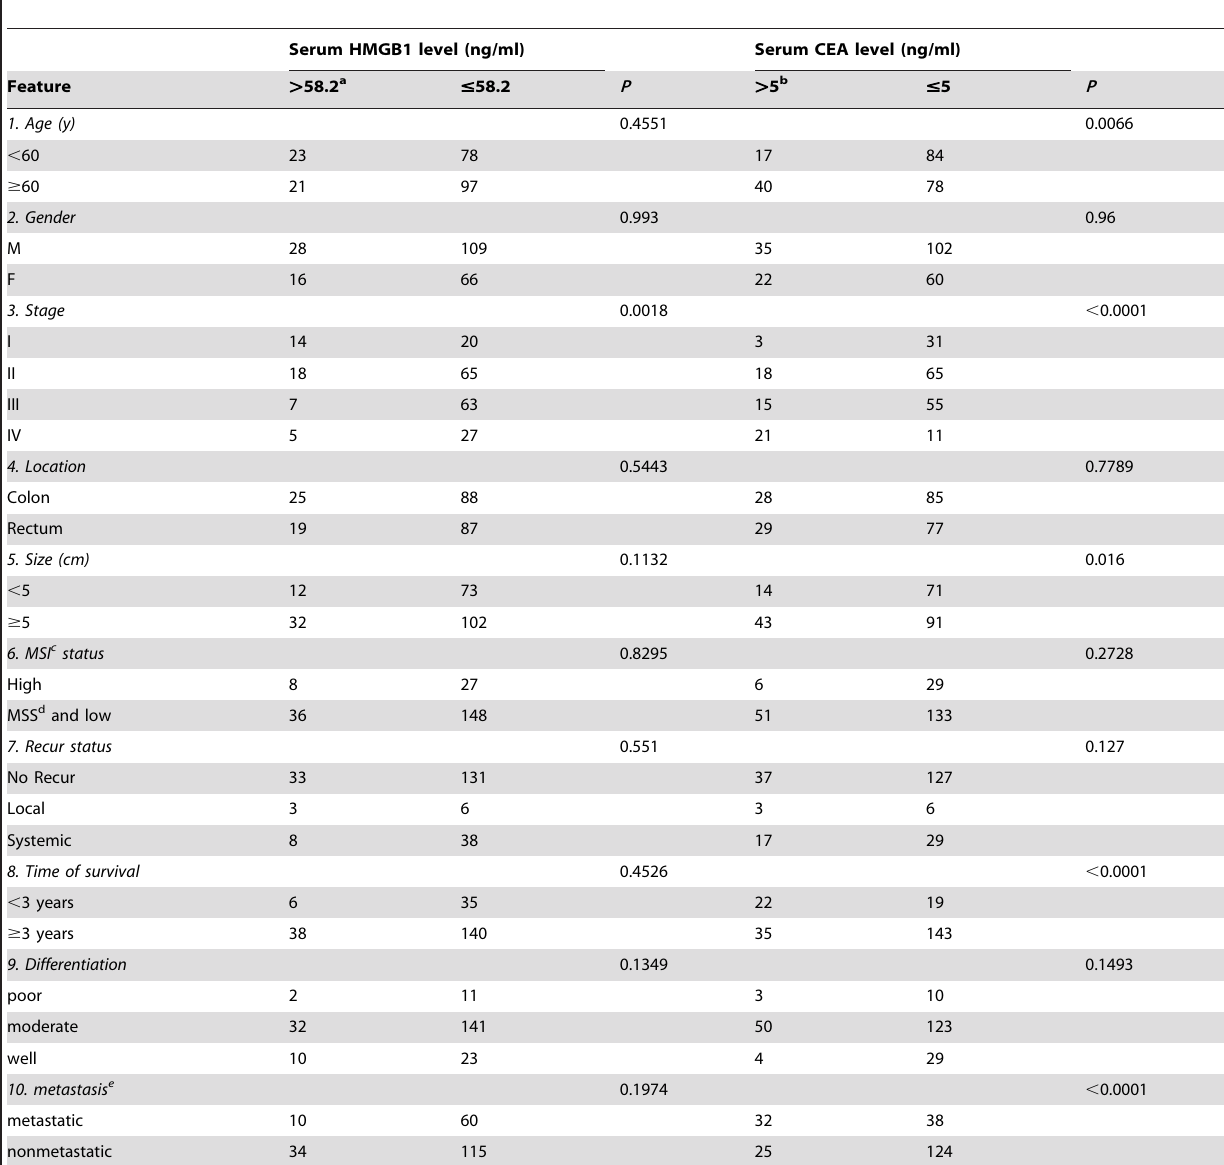
Table 2. Clinicopathologic features of 219 colorectal cancer patients according to serum HMGB1 levels.